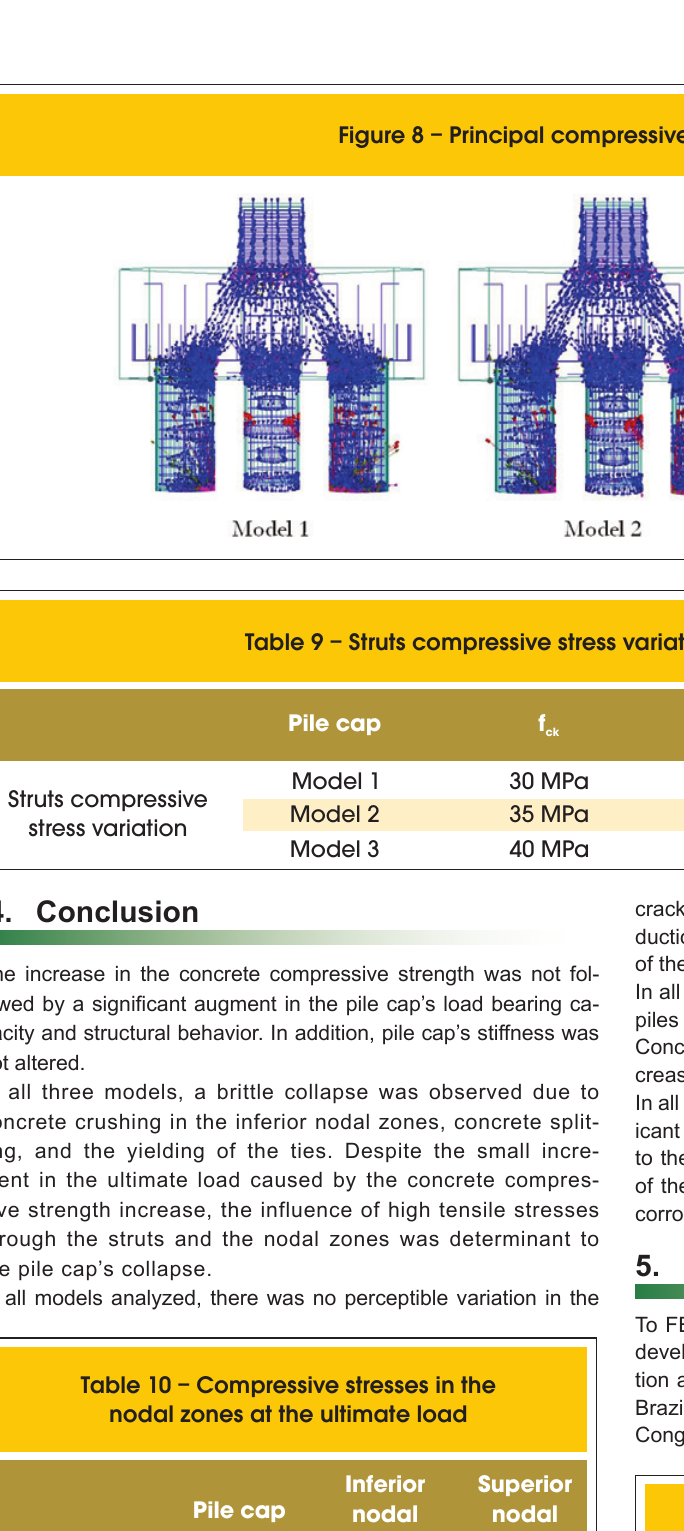
Table 11 – Pile caps tensile